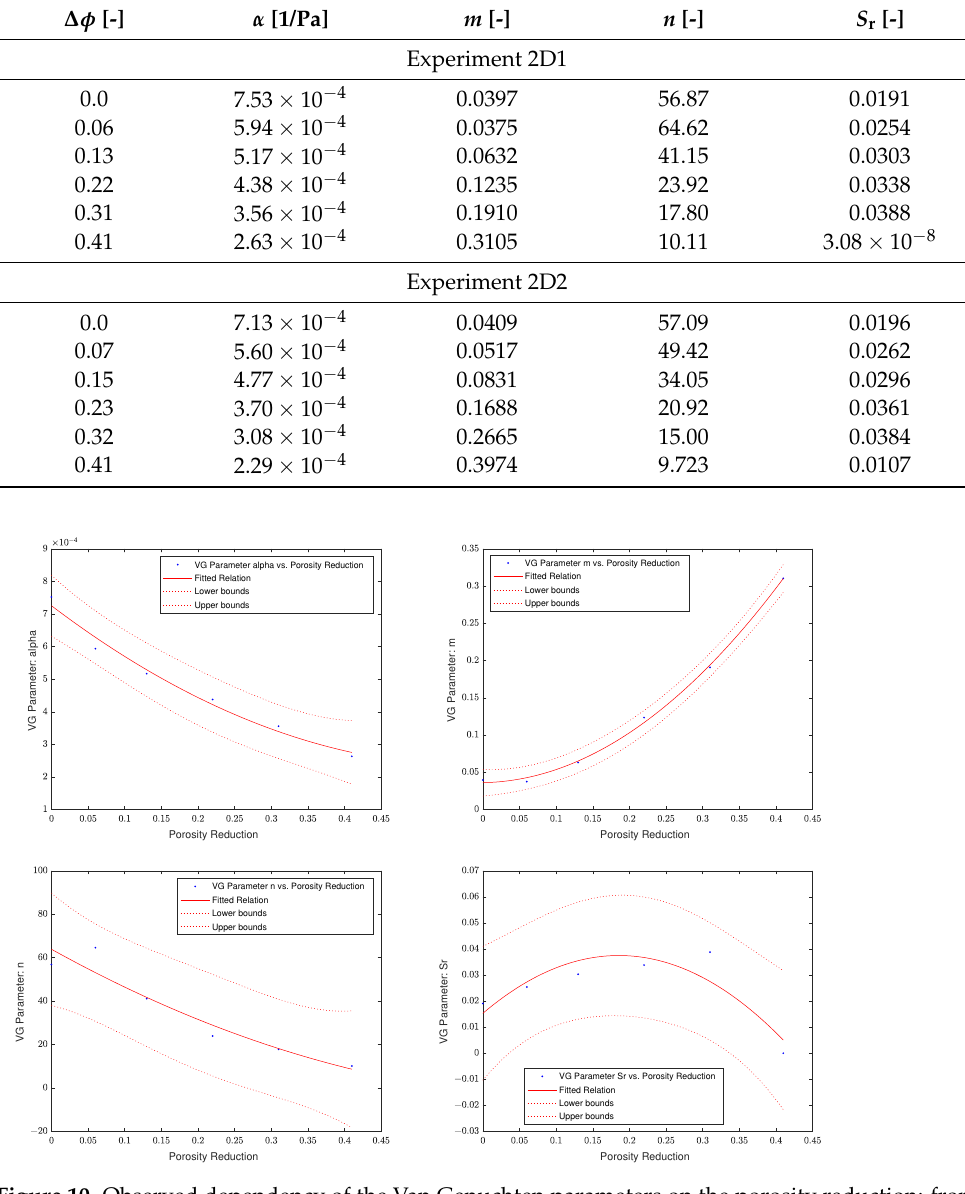
Figure 10. Observed dependency of the Van Genuchten parameters on the porosity reduction: from top left to bottom right, α , m , n , and residual saturation S r for Experiment